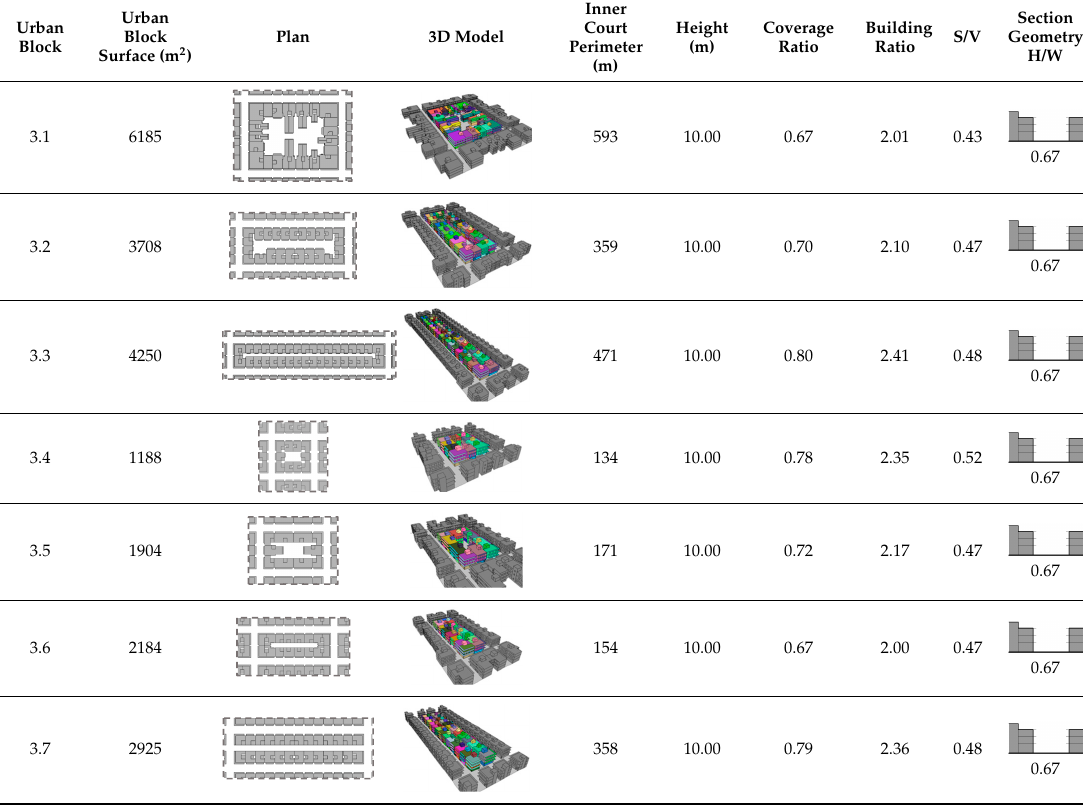
Table 3. Form and geometry parameters of typical urban blocks included in group 3.